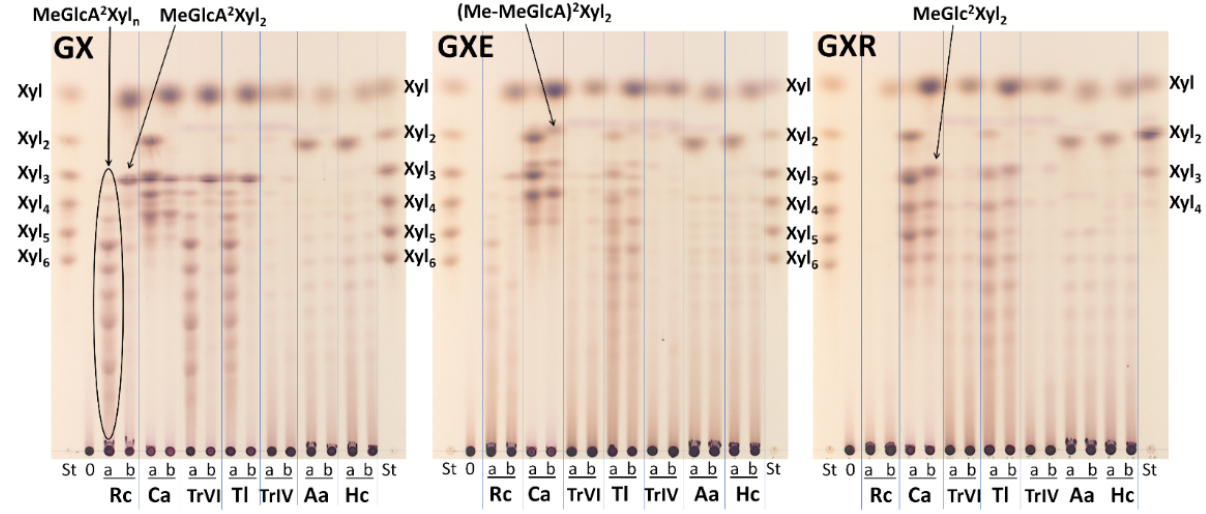
Figure 2. TLC analysis of hydrolysis products of GX, GXE, and GXR by GH30 xylanases. St—standards of linear XOs, a—10 min hydrolysate, b—24 h hydrolysate.